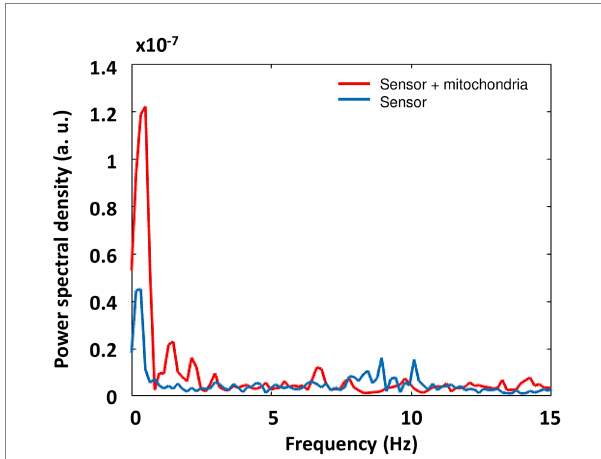
FIGURE 9 PSD profiles of AFM-based mitochondrial nanomotion for sensor without (blue) or with mitochondria (red) attached, with the frequency axis limited to 15